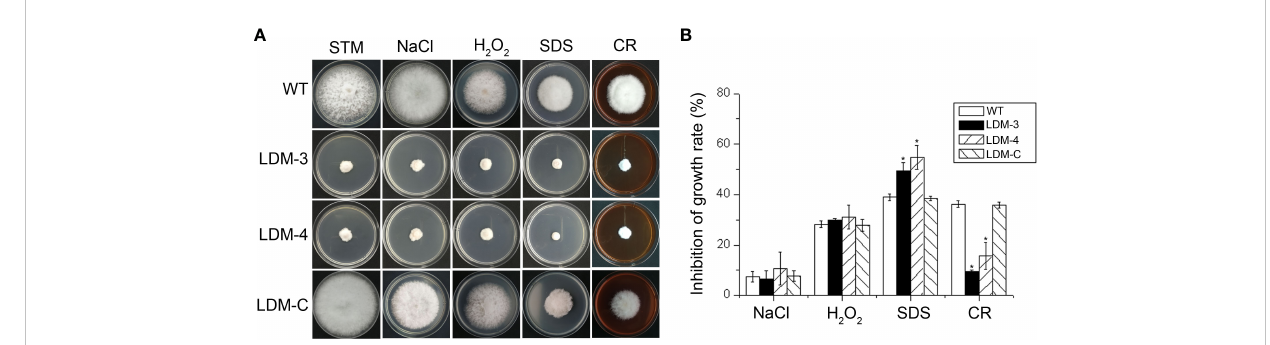
FIGURE 4 Effects of FpLaeB deletion on sensibility to abiotic stress in F pseudograminearum . (A) The wild-type, FpLaeB deletion mutant, and complemented mutant strains grew on synthetic medium (STM) mended with NaCl, H 2 O 2 , SDS, or Congo red (CR). Pictures were taken after 3 dpi on stress media. (B) Inhibition rates were calculated by the growth rate of stress media compared with that of the STM without inhibitor. Mean and standard deviation of data were calculated from three biological replicates. Statistical analysis was performed using Fisher ’ s LSD in SPSS. Asterisks on the bars represent statistically signi fi cant difference compared to wild type ( p < 0.05).